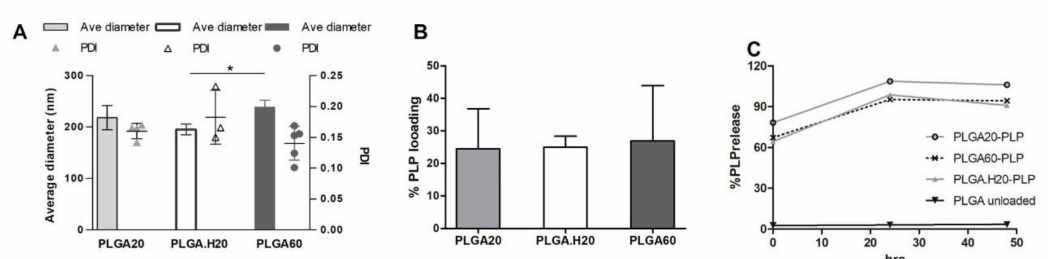
Figure 4. Characterization of PLGA nanoparticles loaded with proteolipid protein (PLP). ( A ) Average diameter and polydispersity index (PDI) of nanoparticles loaded with PLP. ( n = 3, in triplicate) ( B ) loading e ffi ciency of the di ff erent nanoparticle formulations. ( n = 3) ( C ) Release of the PLP